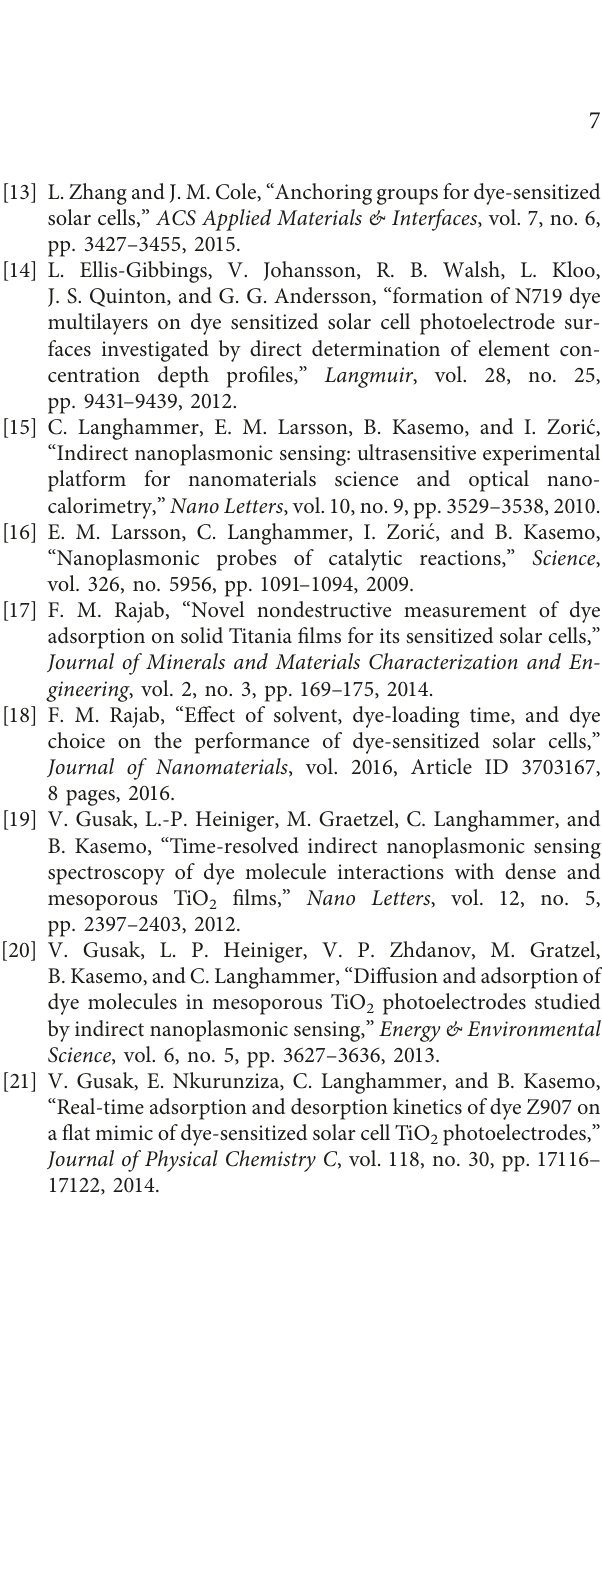
TiO film. Figure S4: (a) IV and (b) quantum efficiency 2 characteristic curves of devices fabricated with 5 μ m mes- oporous TiO films using N719, Z907, and N749 ruthenium 2 dyes. (c) Absorbance at N719 and N749 dye peaks on solid 5 μ m mesoporous TiO films shows correlation with device 2 quantum efficiency. Figure S5: (a) IV and (b) quantum efficiency characteristic curves of devices fabricated with 7 μ m mesoporous TiO films using N719, Z907, and N749 2 ruthenium dyes. (c) Absorbance at N719 and N749 dye peaks on solid 7 μ m mesoporous TiO films shows correlation with 2 device quantum efficiency. ( Supplementary Materials